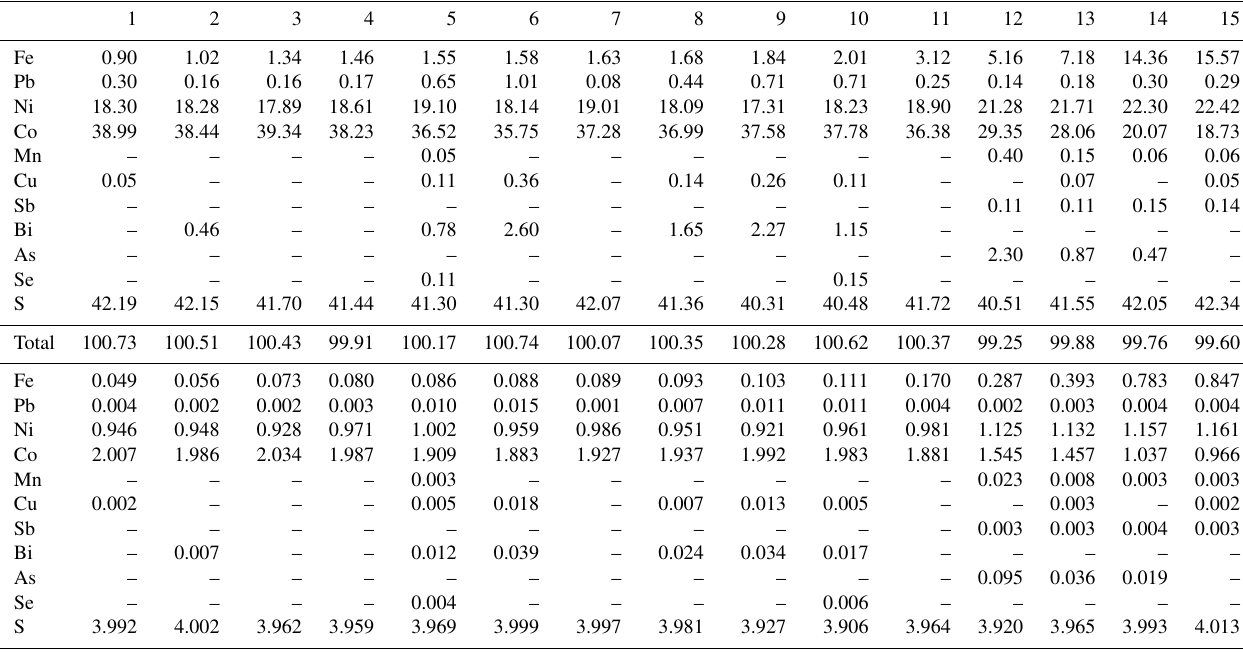
Table 3. Representative analyses (wt%) for grimmite from Pˇríbram.